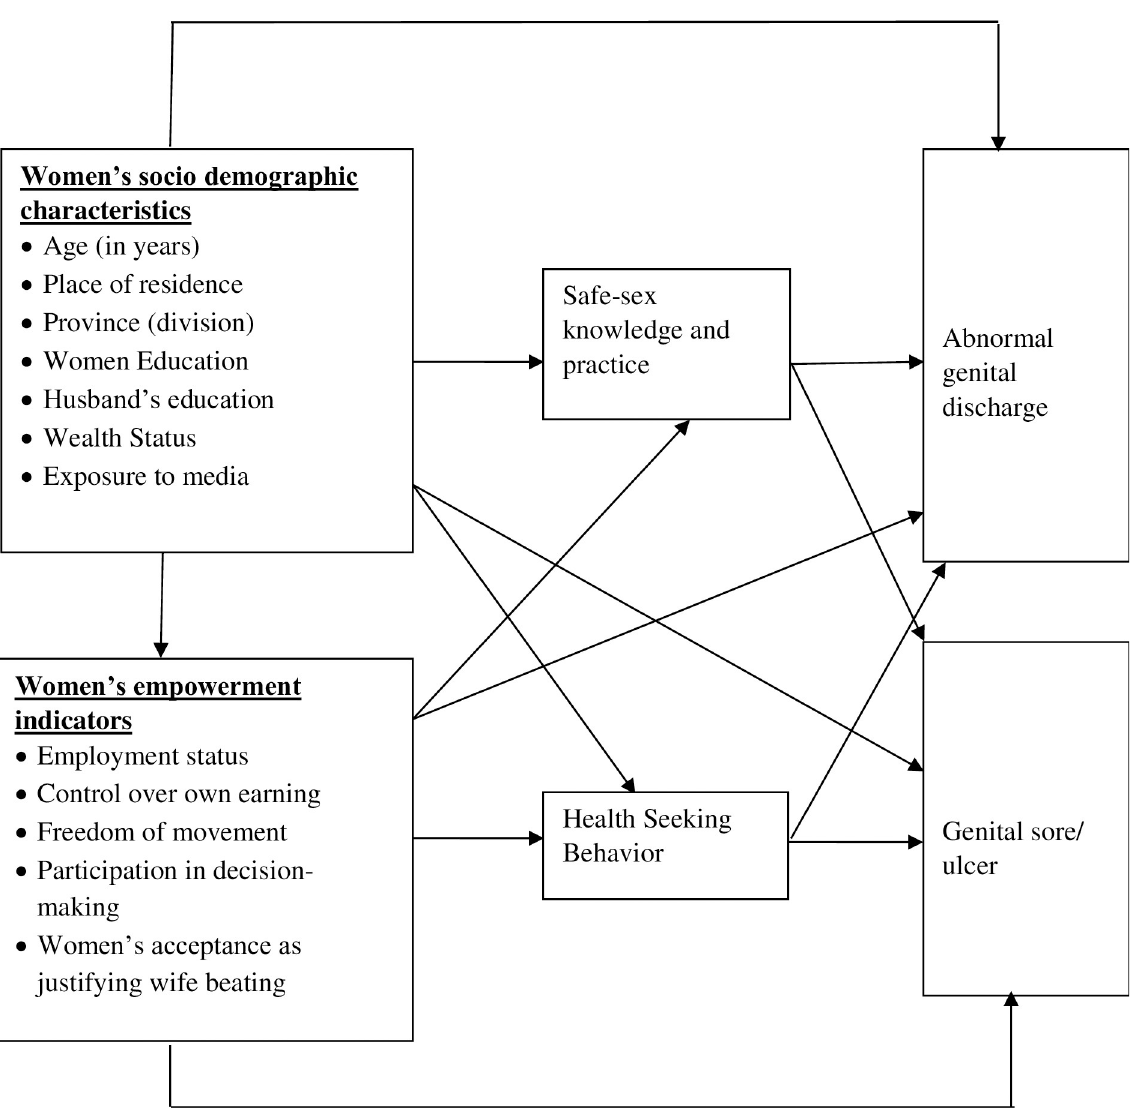
Fig 2. The conceptual framework illustrating the causal pathway between women empowerment indicators and outcome of